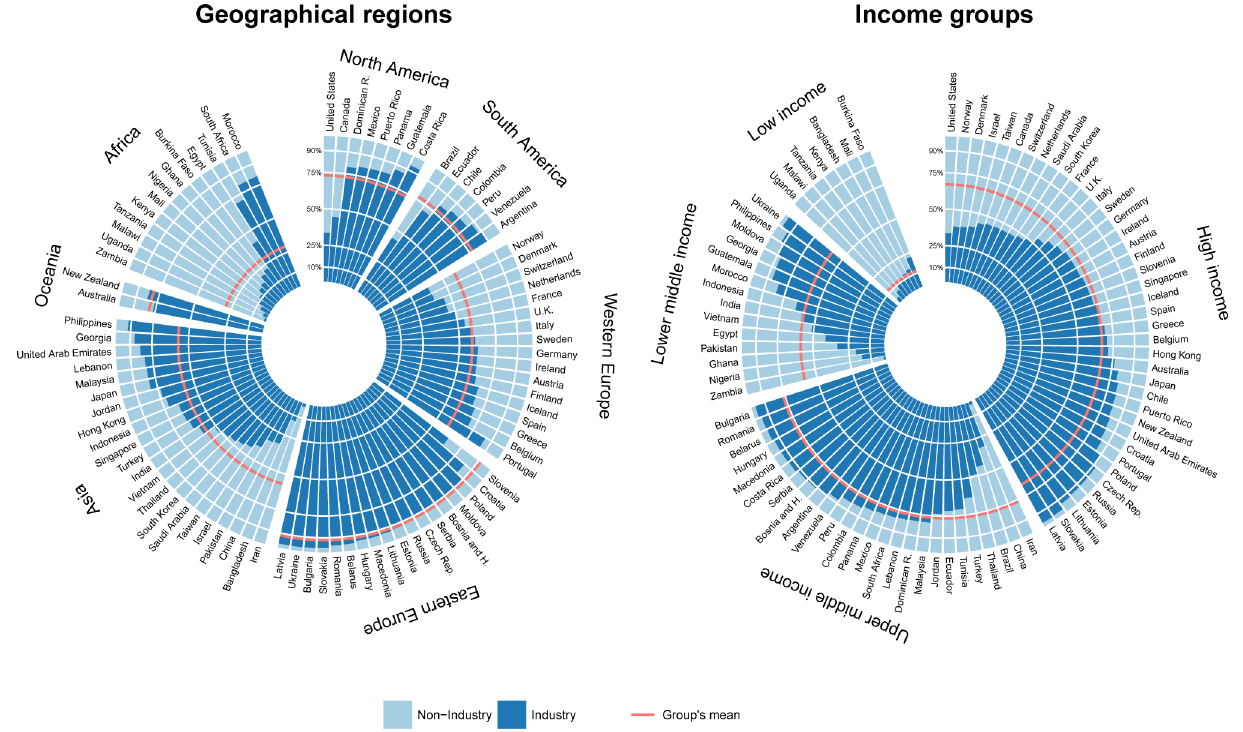
Fig 2. Sponsorship ratios of clinical trials. The radial barplot shows the proportion of industry- sponsored clinical trials (in dark blue) in the 87 countries where at least 50 trials were initiated during the 2006 – 2013 period. Countries were grouped by (a) geographical region and (b) income groups. For each group of countries, the red line represents the mean proportion of industry-sponsored clinical trials. The exact sponsorship ratios per country can be found on S4 Table. In high-income countries the proportion of industry-sponsored trials ranged from 33.6% in the United States to 90% or more in seven Eastern European countries. In upper-middle- income countries, the proportion ranged from 2.1% for Iran to more than 97% for countries such as Bulgaria and Romania. In lower-middle-income countries, the proportion ranged from less than 20% in three African countries to 97.2% in Ukraine.